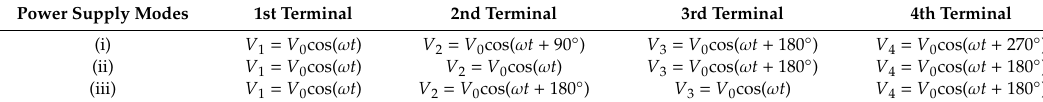
Table 1. AC voltage sequence for the three distinct power supply modes.